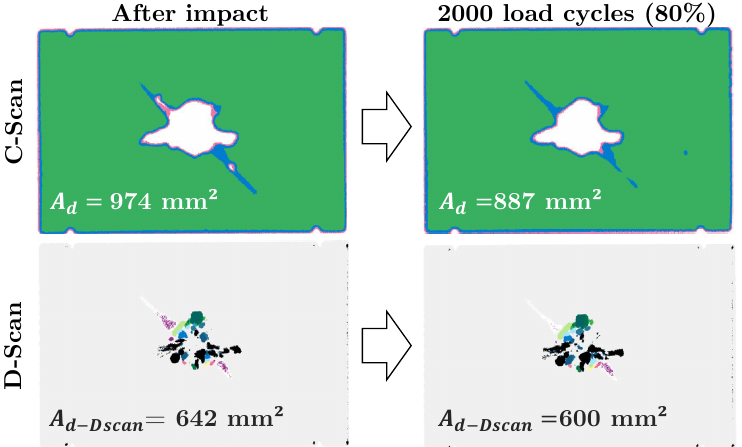
Figure 7. Example for the apparent shrinking of the delamination area A d after 2000 load cycles at a load level of 80%.